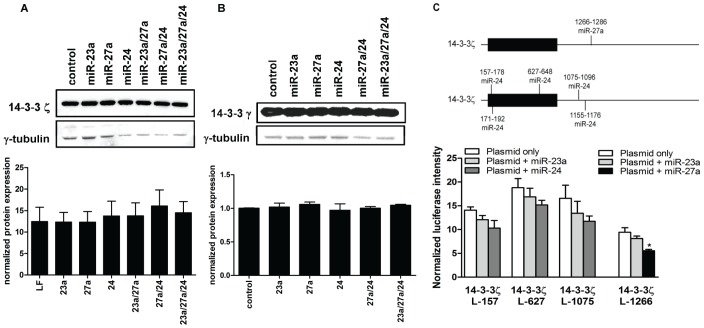
The miR-23a cluster does not regulate 14-3-3ζ, or other 14-3-3 isotypes.(A) and (B) The effect of the miR-23a cluster on (A) 14-3-3ζ and (B) 14-3-3γ protein expression was measured via Western blot. The top panels are representative blots from one experiment, and the bottom panels are graphs of normalized protein expression from 3 independent experiments (±SEM), determined by densitometry analysis (p<0.05*). (C) The schematics show predicted miR-27a and miR-24 binding sites in the CDS and 3′UTR of 14-3-3ζ (top panel). HEK293T cells were co-transfected with 14-3-3ζL-157, 14-3-3ζL-627, or 14-3-3ζL-1075 (500 ng, white bars) alone and with 25 nM of miR-23a (light grey bars) or miR-24 (dark grey bars); HEK293 cells were also co-transfected with 14-3-3ζL-1266 (500 ng, white bars) alone and with 25 nM of miR-23a (light grey bars) or miR-27a (black bars) (bottom panel). Normalized mean Luc expression (±SEM, n≥3) is represented on the graphs.